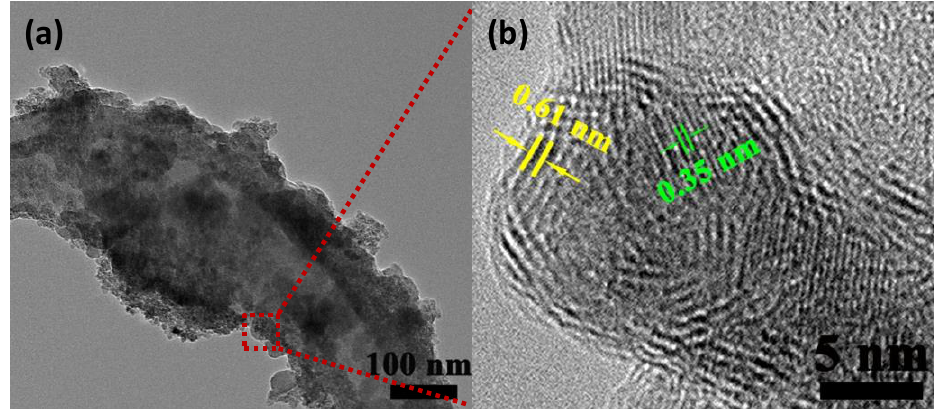
Figure 4. TEM image of TiO 2 /PVDF@MoS 2 core-shell heterostructured fiber ( a ) and high-resolution TEM image of TiO 2 /PVDF@MoS 2 core-shell heterostructured fiber ( b ).